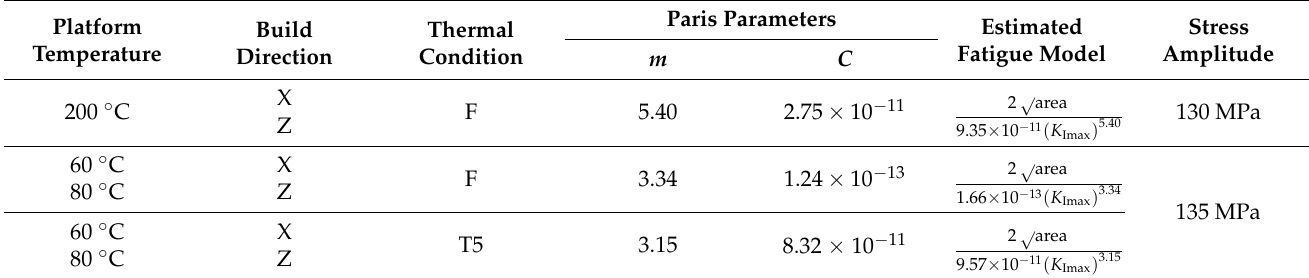
Table 5. Paris parameters and estimated fatigue models for the additively manufactured AlSi7Mg conditions tested in this work. Platform